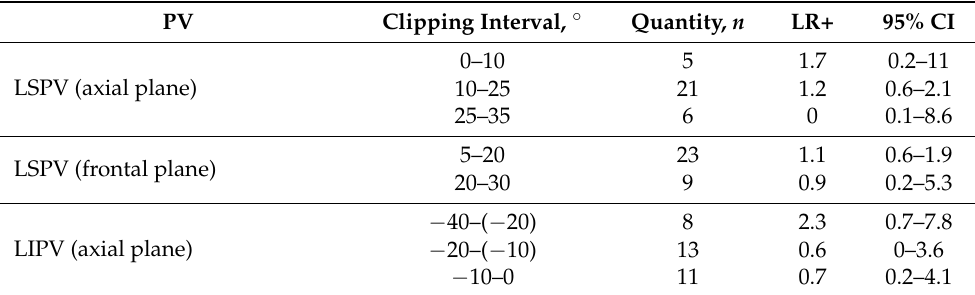
Table 5. Influence of PV angulation on long ‐ term results.